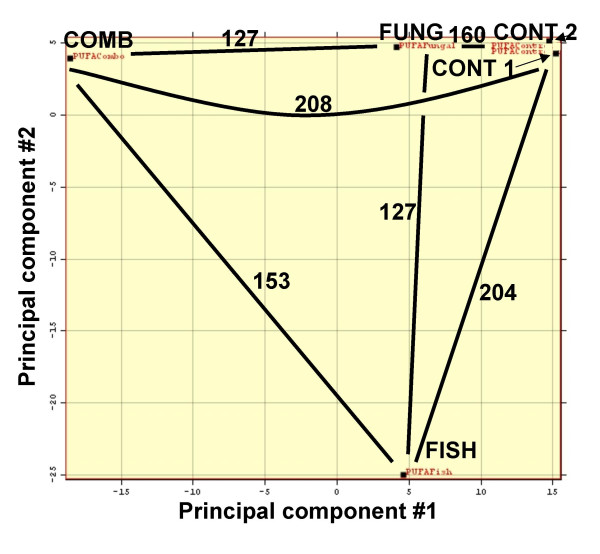
Principle component analysis scatter plot showing the five arrays used, represented by 371 most highly differentiated probe sets. Spatially closest arrays have the most similar genomic profiles. Super imposed are numbers of probes sets significantly different at P < 0.001 in six pair wise comparisons. Probes differing between arrays would not necessarily be the same in each comparison. PUFAConrol, Control diet; PUFAFungal, arachidonate-rich fungal oil; PUFAFish, fish oil; PUFACombo, combination diet.